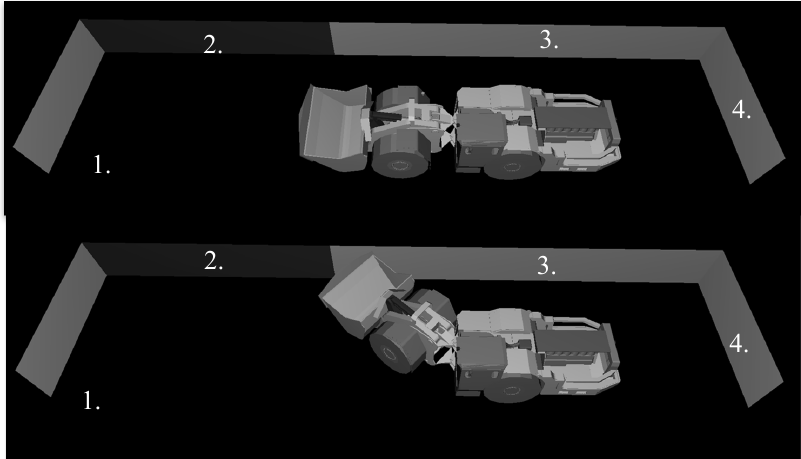
Figure 1. LHD straight and articulated 38.6° in a straight drift.